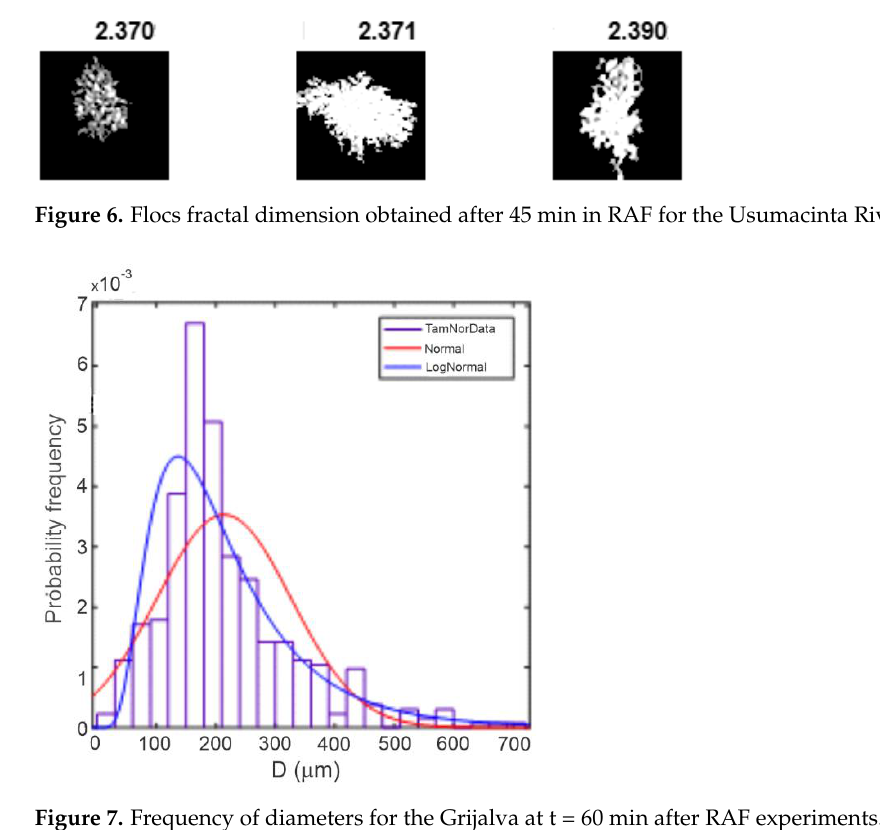
Figure 7. Frequency of diameters for the Grijalva at t = 60 min after RAF experiments.